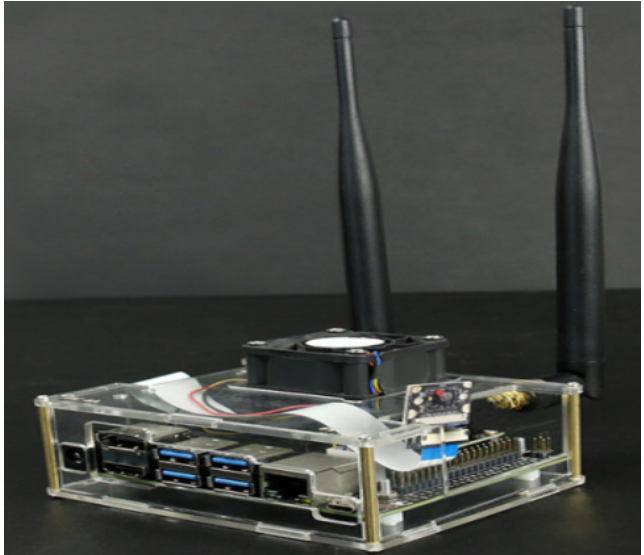
Figure 2. Image recognition module equipment.